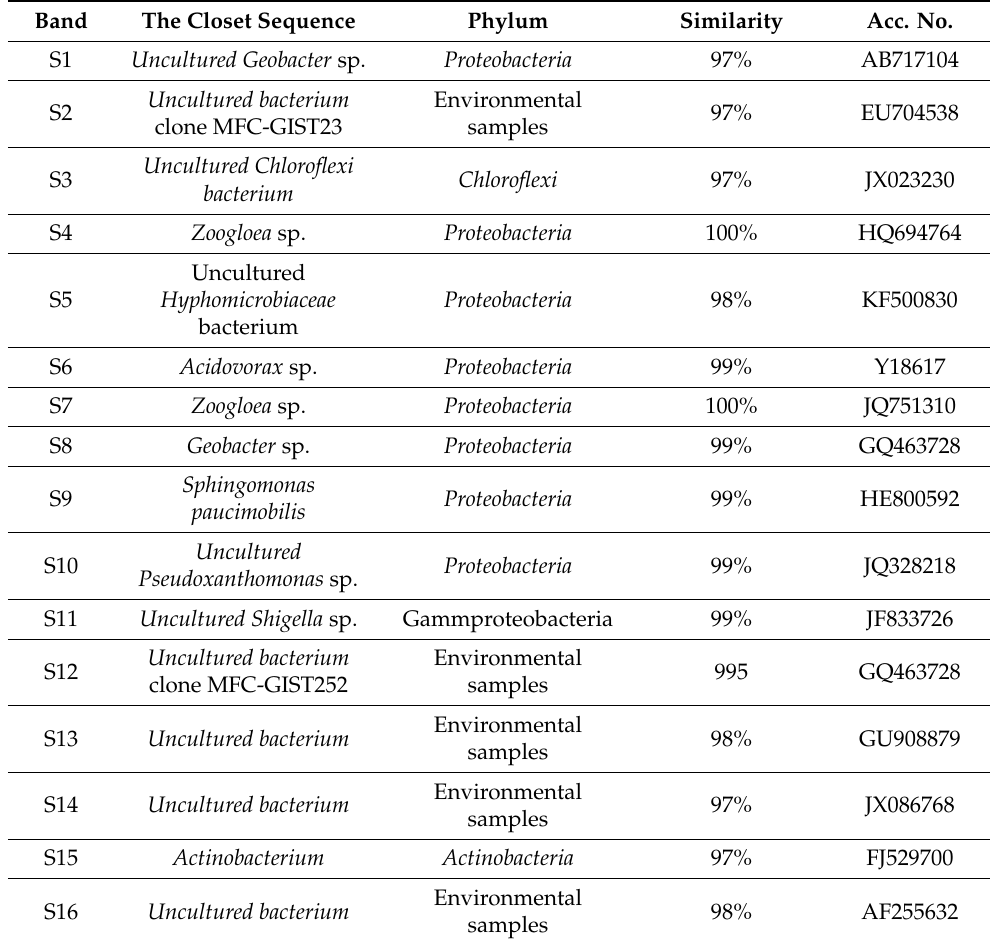
Table 2. Sequence analysis of denaturing gradient gel electrophoresis (DGGE) bands for EBR using synthetic wastewater (WW).